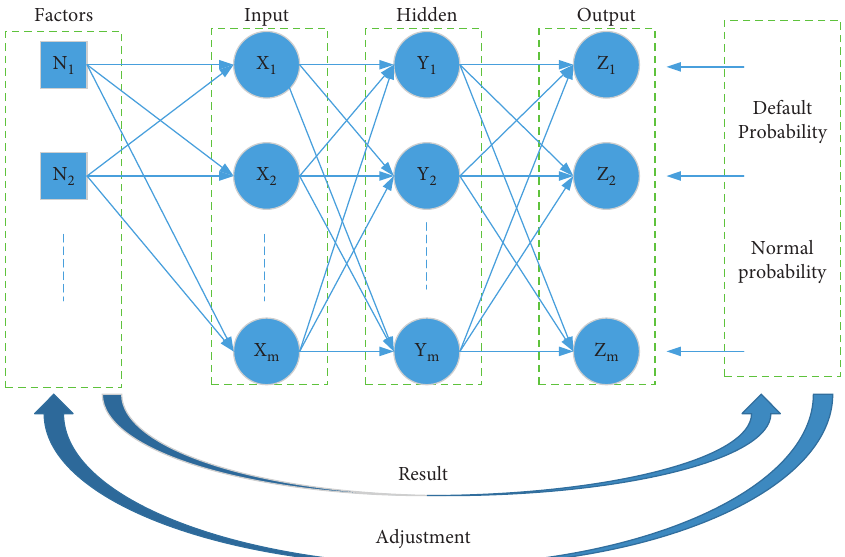
Figure 2: Topology for neural networks.